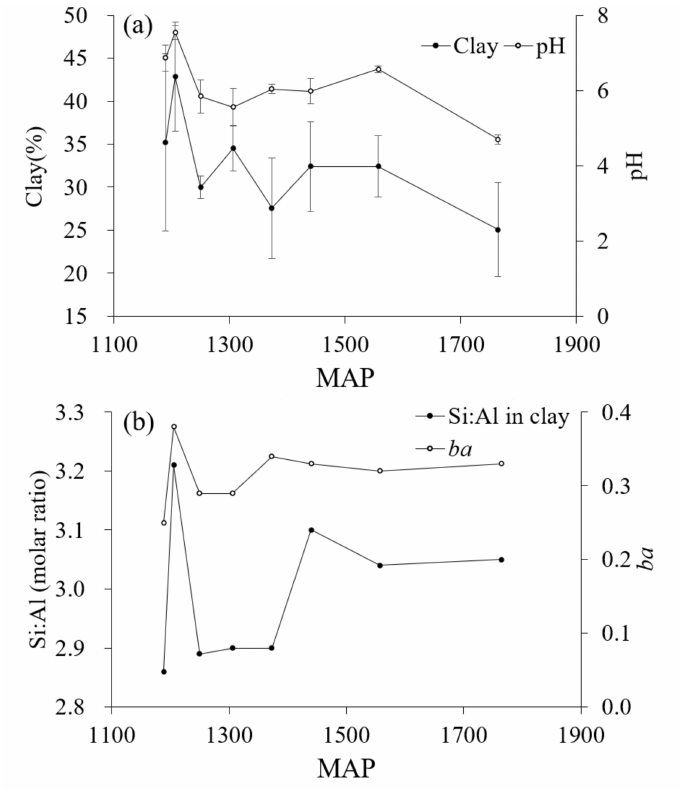
Figure 5. ( a ) The average content value of clay and pH, and the error bars represent standard deviations of each pedon, ( b ) the Si:Al molar ratio of the clay fraction and base-alumina ratio in the stable horizon ( ba ;